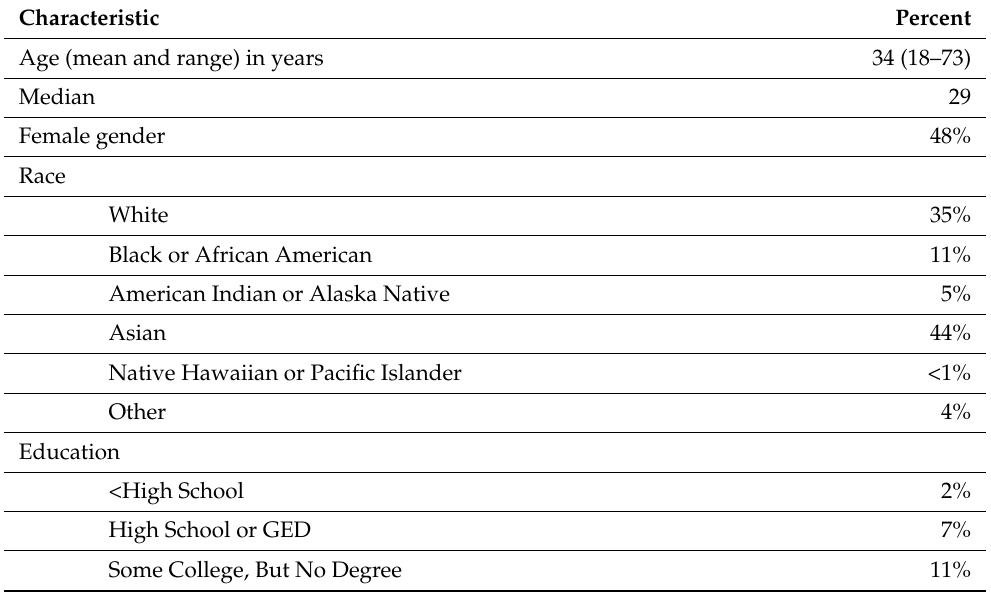
Table A2. Participant